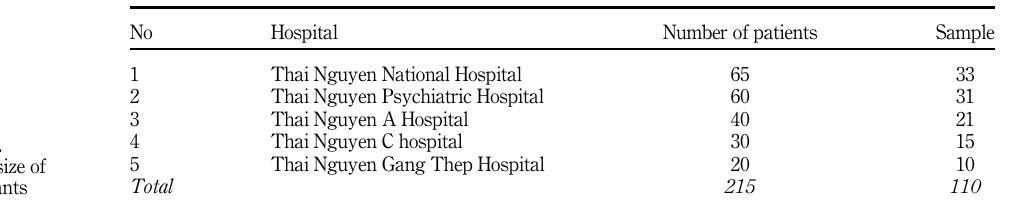
Table I. Sample size of